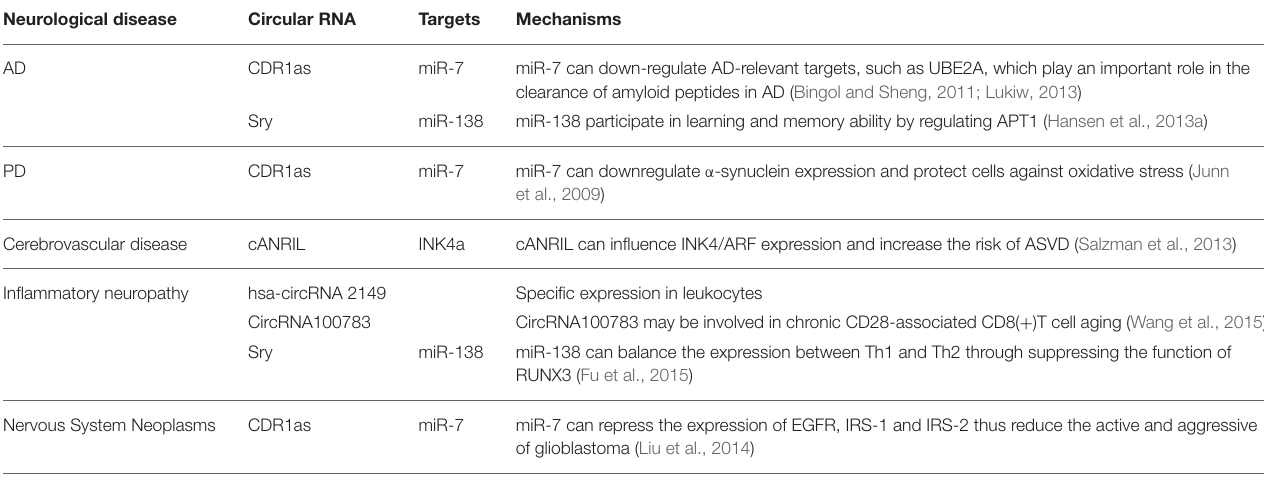
TABLE 1 | Functional mechanism of Circular RNAs in neurological disease. Neurological